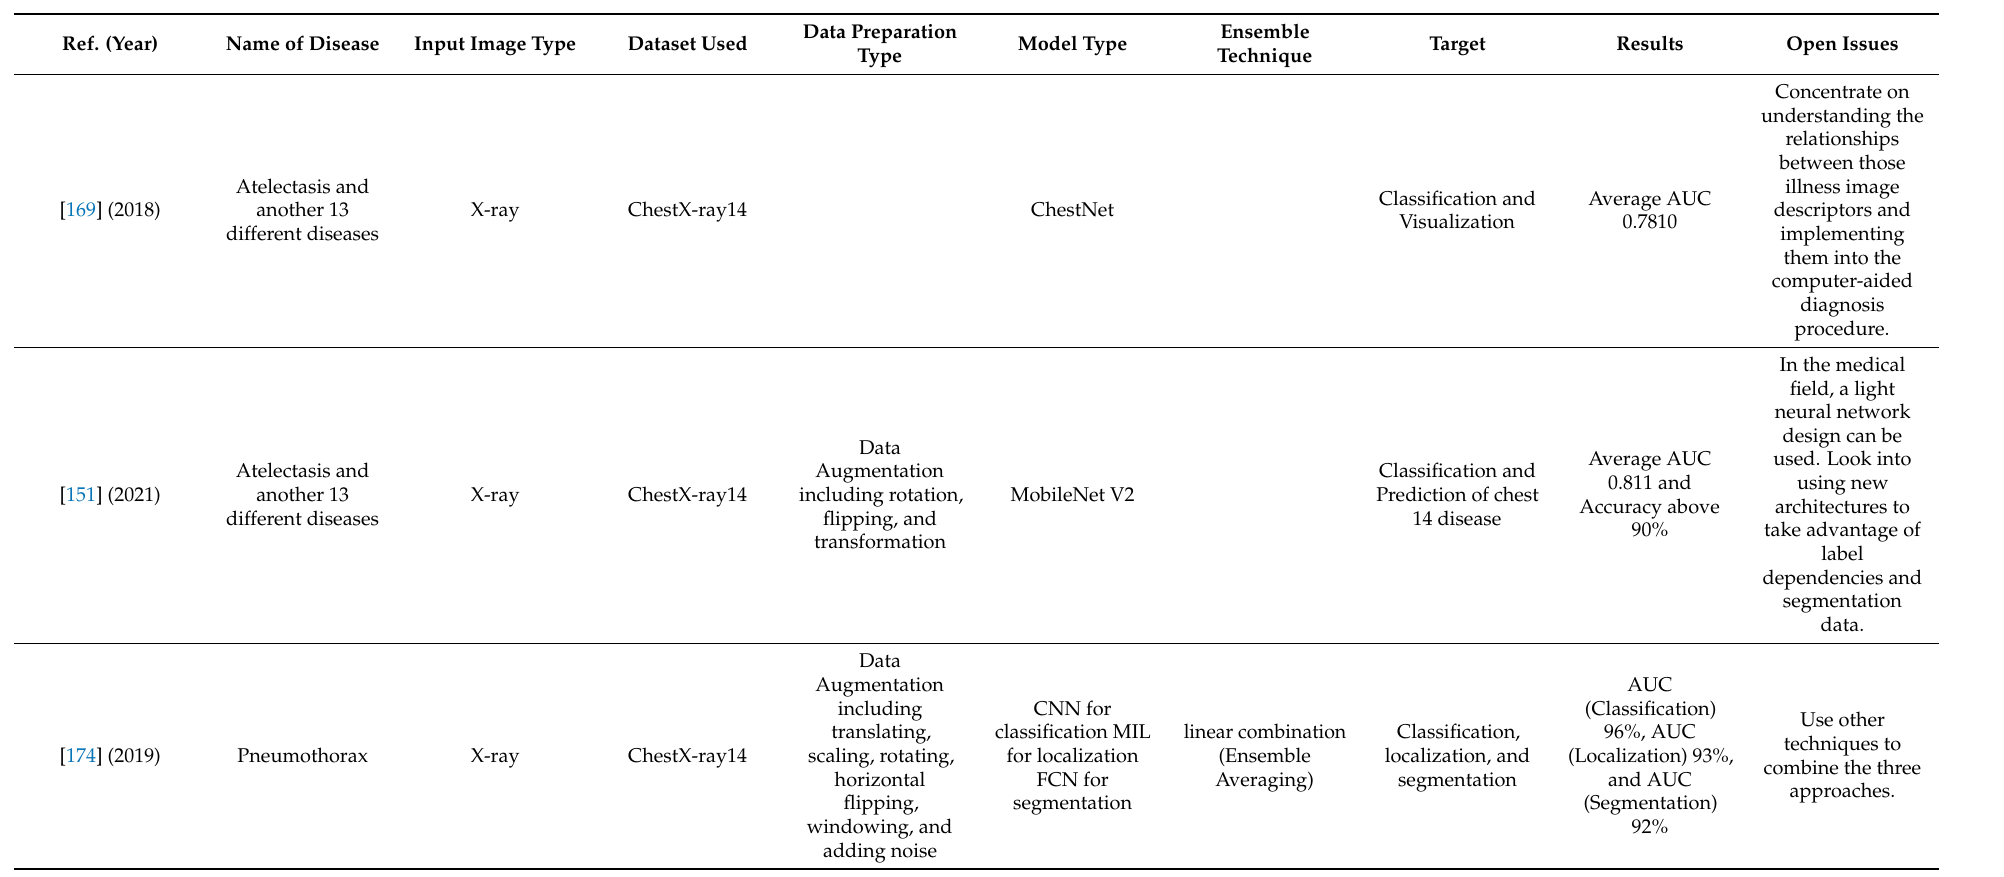
Table 5. Atelectasis, Pneumothorax, and Infiltration diseases detection